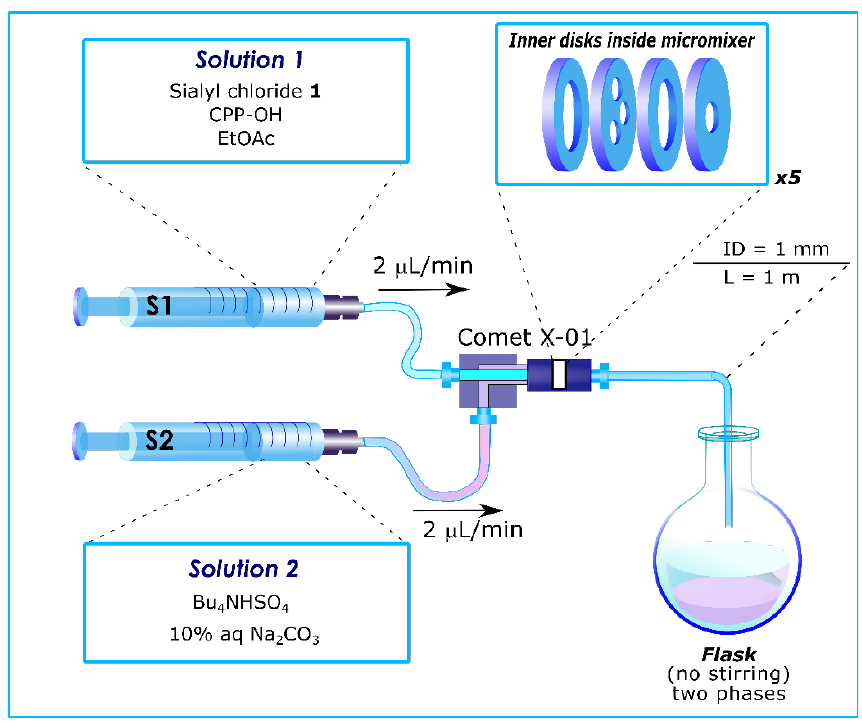
Scheme 1. Glycosylation reaction with N -acetylsialyl chloride 1 under flow conditions. Reagents Figure 1. Flow reactor used for glycosylation experiments. S1 , S2 —syringes. Internal volume of and conditions: 4-(3-chloropropoxy)phenol (CPP-OH, 2 equiv.), Bu 4 NHSO 4 (1 equiv.), AcOEt, 10% Comet X-01 micromixer–0.1 mL, that of outlet capillary—0.785 mL. Adapted from [33] by permis- aq Na 2 CO 3 , Comet X-01 micromixer (see Figure 1 for experimental setup). Flow rate 2 μL/min was sion. used. Concentration of 1 varied in 5–200 mmol/L range. See Table 1. Table 1. Results of PTC glycosylation of CPP-OH by N -acetylsialyl chloride 1 under flow conditions at various concentrations. Entry 1 C , mmol/L Yield of 2, % 2 α/β 2 Yield of 3, % 2,3 Conversion of 1, % 2